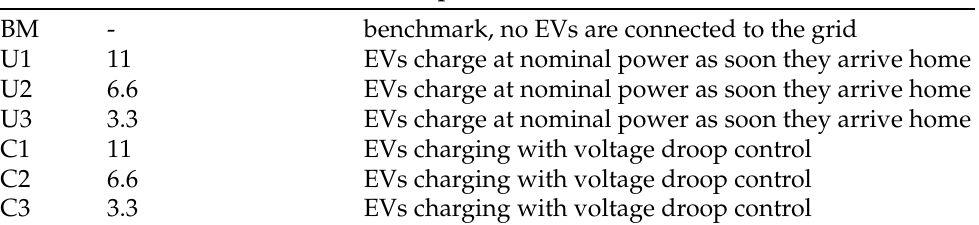
Table 2. Overview of the scenarios considered in the simulations: benchmark scenario (BM), un- controlled scenarios (U1–U3) and controlled scenarios (C1–C3) for three different charging power ratings